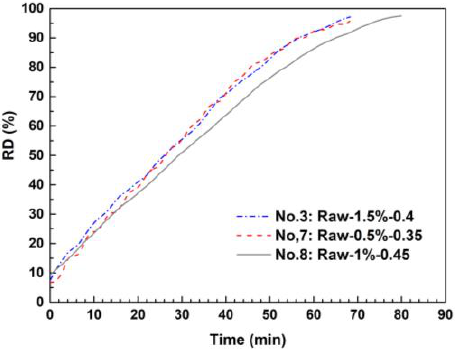
Figure 4. The reduction curves of raw magnetite samples.